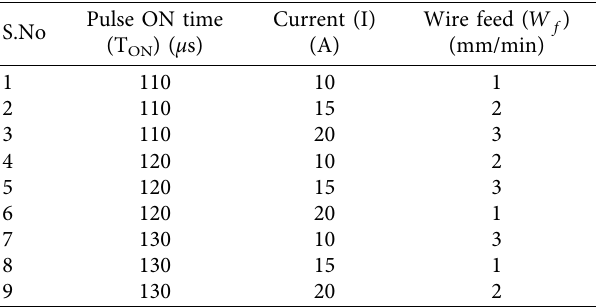
Table 2: Experimental data for